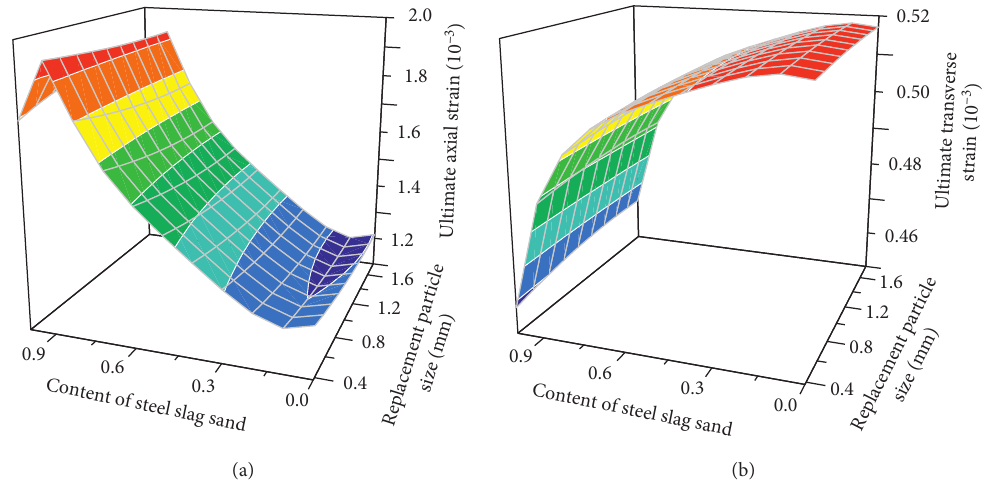
Figure 24: The impact of the content and replacement particle size of steel slag sand on the ultimate strains. (a) Ultimate axial strain. (b) Ultimate transverse strain.